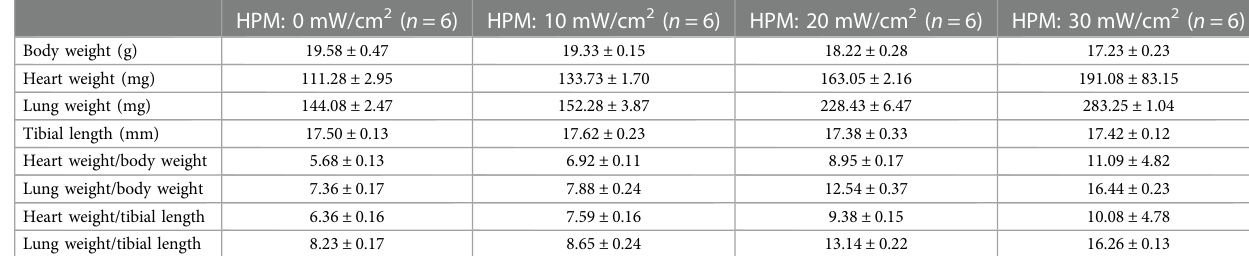
TABLE 1 Body weight, heart and lung weight tibia length parameters in different HPM